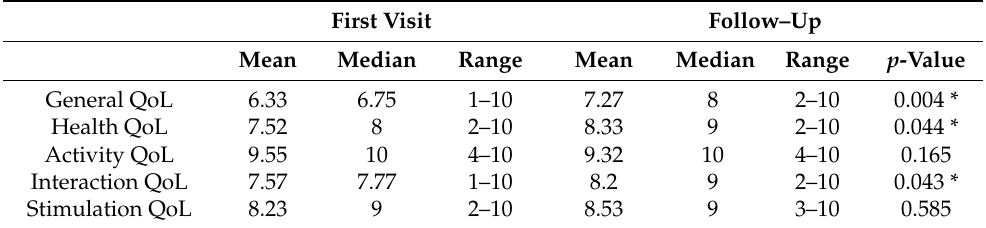
Table 1. Comparison of QoL scores on first visit and follow-up in enteropathic dogs (* = p < 0.05).